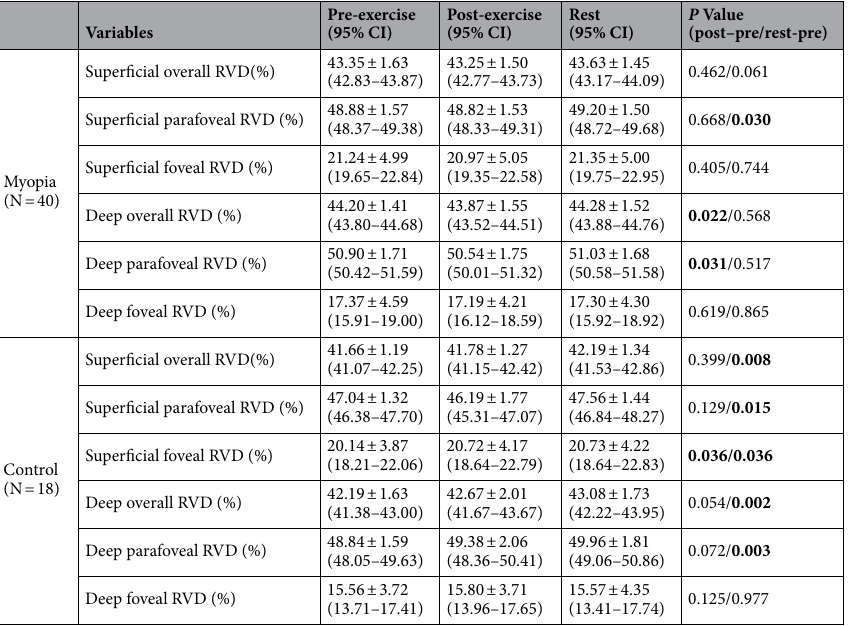
Correlations among SS-OCT, SS-OCTA, and hemodynamic parameters. Changes in HR were negatively correlated with changes in CT% (Pearson’s correlation r = − 0.327, p = 0.04, Fig. 4A) and changes in SFCT% (Pearson’s correlation r = − 0.345, p = 0.03, Fig. 4B) in myopic eyes. This correlation was not observed in emmetropic eyes. There were no significant correlations between ΔHR and other SS-OCTA parameters in both myopic and emmetropic eyes. No significant correlations were detected among ΔSBP, ΔCT%, and other SS-OCTA parameters.